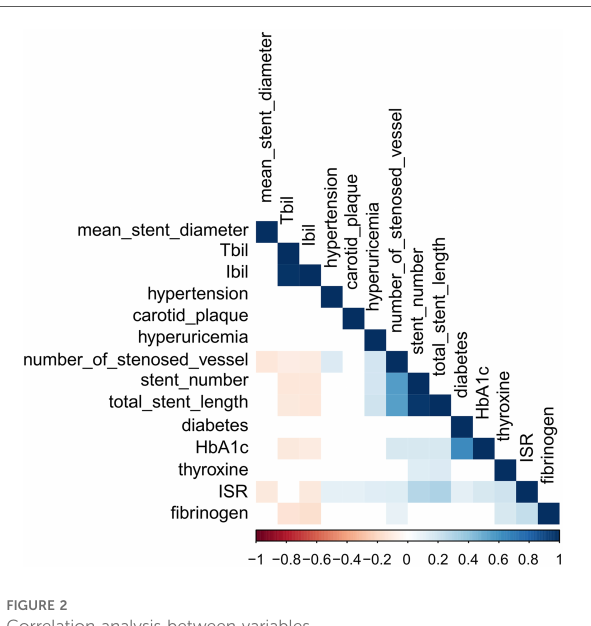
FIGURE 2 Correlation analysis between